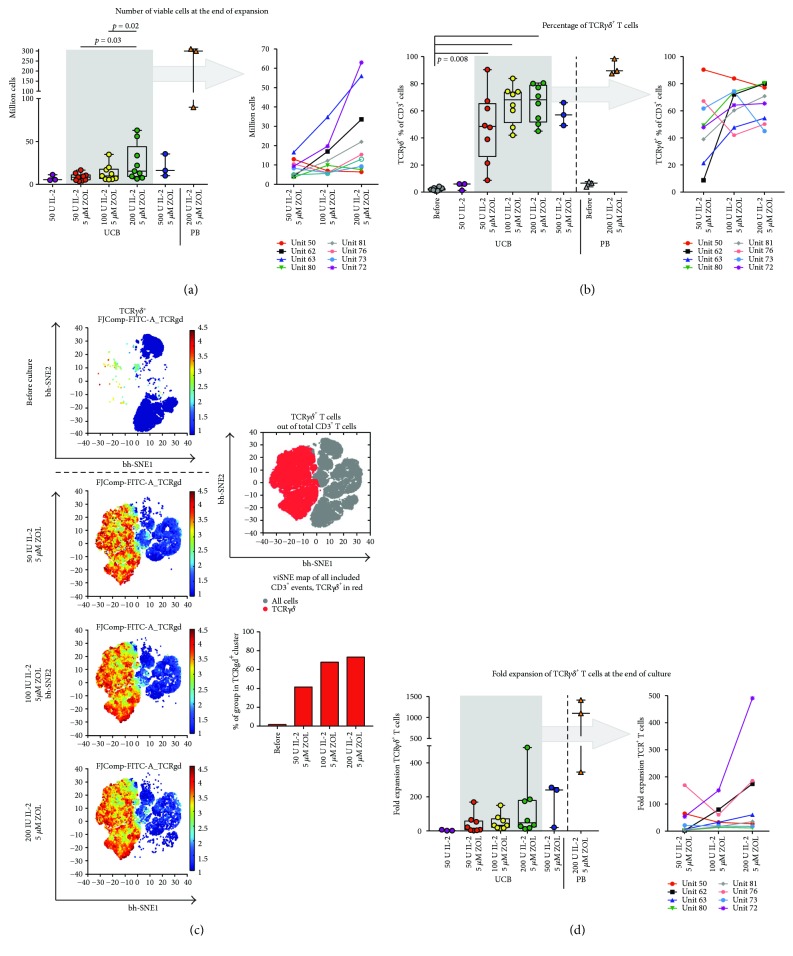
Expansion of γδ T cells. The number of viable cells after 14 days of culture is displayed according to culture conditions in (a). Here, and in (c) and (d), the grey box in the left graph encompasses the results of UCB γδ T cells cultured with 5 μM zoledronate and 50, 100, or 200 IU IL-2/ml medium, and in the in right graph, indicated by the arrow, the data inside the box is displayed separately for each cultured UB unit (each unit is indicated by a differently colored line). In (b) and (c), the proportion of γδ T cells is visualized in two different manners. In (b), the percentage of TCRγδ
+ T cells is shown before and after culture. In (c), the same data is displayed for expansions of UCB cells using the bh-SNE algorithm to analyze and visualize the data. The panels to the left display the fluorescence intensity in the flow cytometry channel for TCRγδ, normalized using arcsin transformation with cofactor 150, for every cell in the displayed groups. In the top right panel, an overview of the cells in all samples is displayed and gated according to where the TCRγδ
+ cells are clustered. The lower right panel shows the percentage of cells in each group found in the TCRγδ
+ cell cluster. The fold expansion of γδ T cells is displayed in (d). IL-2: interleukin 2; TCR: T cell receptor; ZOL: zoledronate.